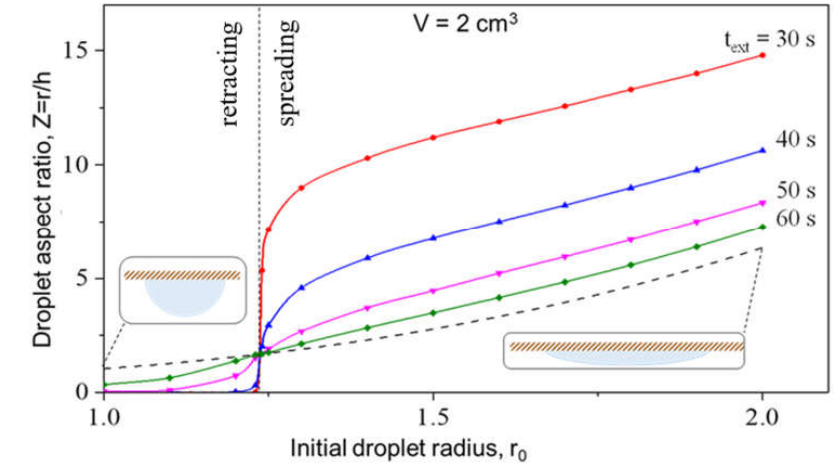
Figure 5. Initial (dashed line) and final (full line) droplet aspect ratios, i.e., Z = r / h , for different extrusion times and initial droplet contact radii, r 0 . ( V = 2 cm 3 , γ = 45 mN/m).